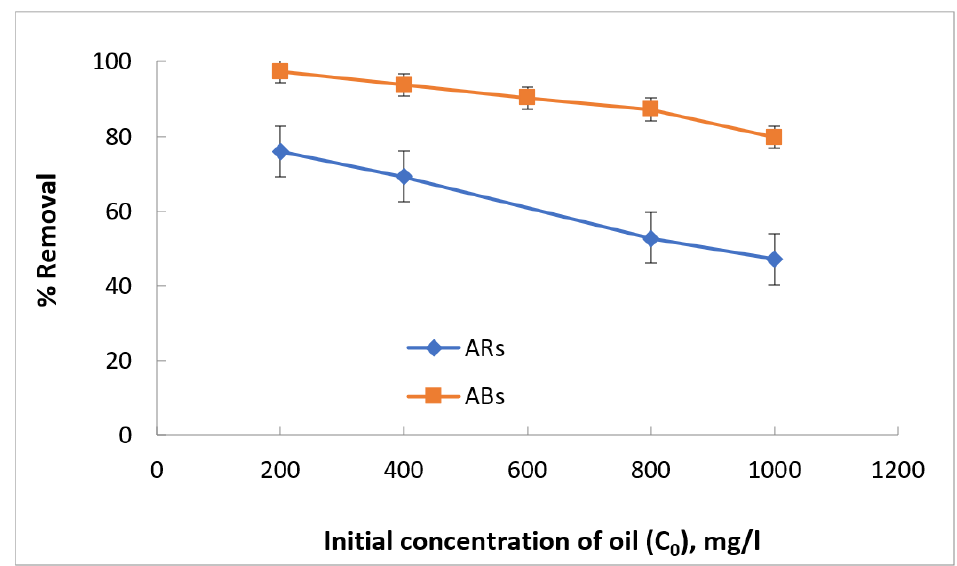
Figure 12. The impact of initial concentration of oil on the percentage of oil onto ( ABs and ARs (1 g adsorbent, pH 6.5, Temp. 25 ◦ C, 60 min).